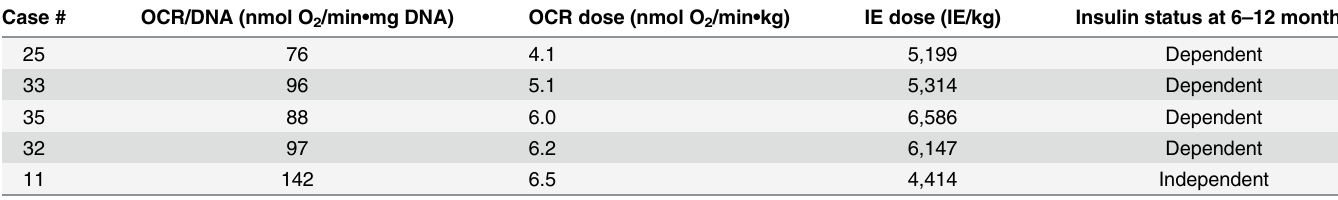
Table 2. Summary of cases where OCR dose correctly predicted clinical transplant outcome, whereas IE dose did not. Case # OCR/DNA (nmol O 2 /min (cid:129) mg DNA) OCR dose (nmol O 2 /min (cid:129) kg)